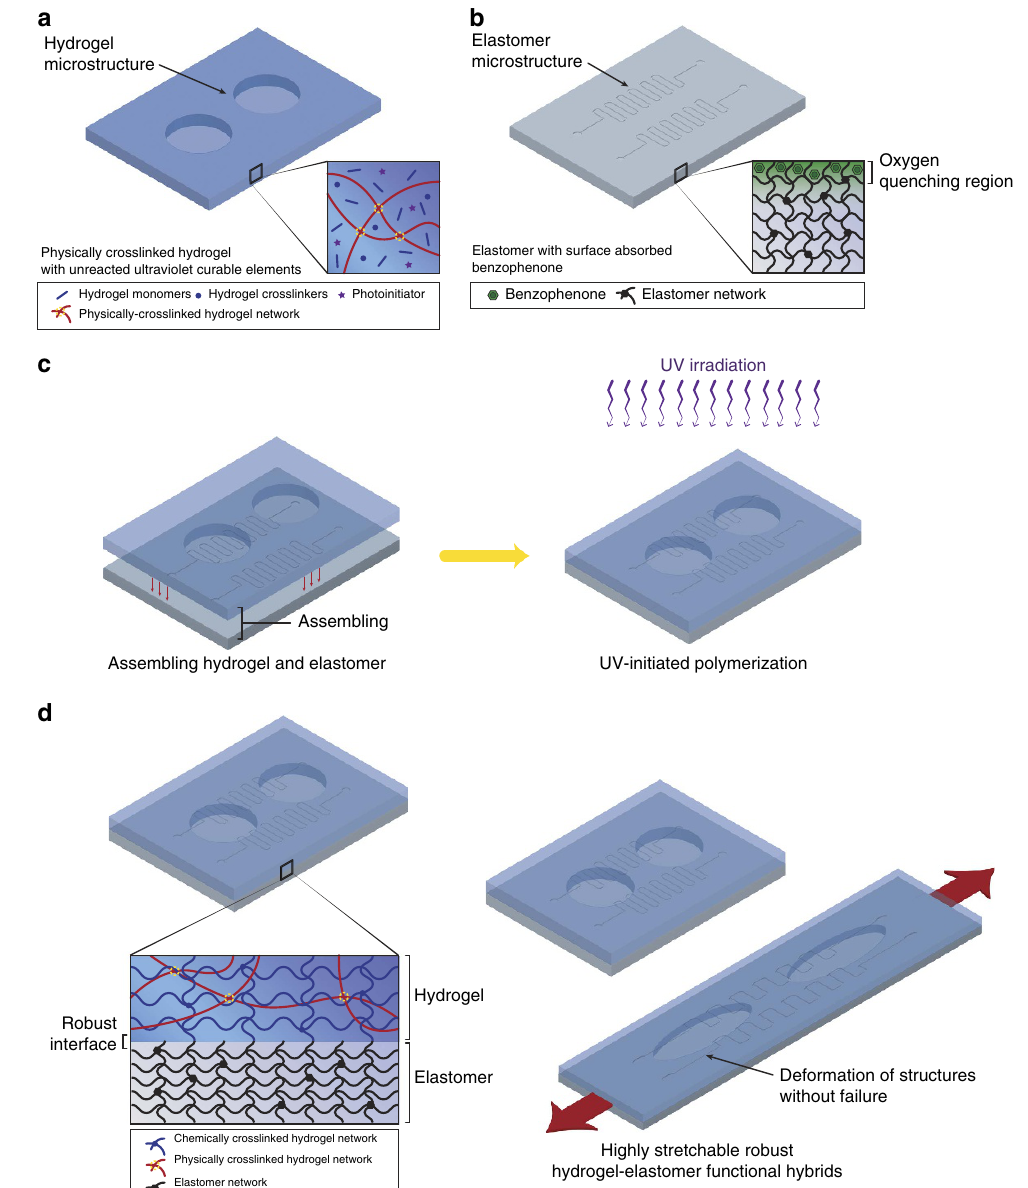
Figure 1 | Schematic illustration of the fabrication of robust microstructured hydrogel–elastomer hybrids. ( a ) The hybrids are formed by bonding tough hydrogels of interpenetrating polymer networks with elastomers. One polymer network of the hydrogel is first physically crosslinked, while infiltrated with monomer/macromonomer solution of the other polymer network. The physical crosslinking sets the shape and microstructures of the hydrogel. ( b ) The surface of a cured elastomer with patterned microstructures is treated with benzophenone. ( c ) The pre-shaped hydrogel and elastomer are assembled together followed by ultraviolet irradiation to chemically crosslink the other polymer network in the hydrogel. ( d ) After ultraviolet irradiation, the resultant hydrogel–elastomer hybrid forms extremely robust interfaces due to the covalently anchored polymer network in the hydrogel on elastomer surface. The pre-patterned microstructures in elastomers and hydrogels are also preserved in the hybrid. The hybrids can be highly stretched without interfacial